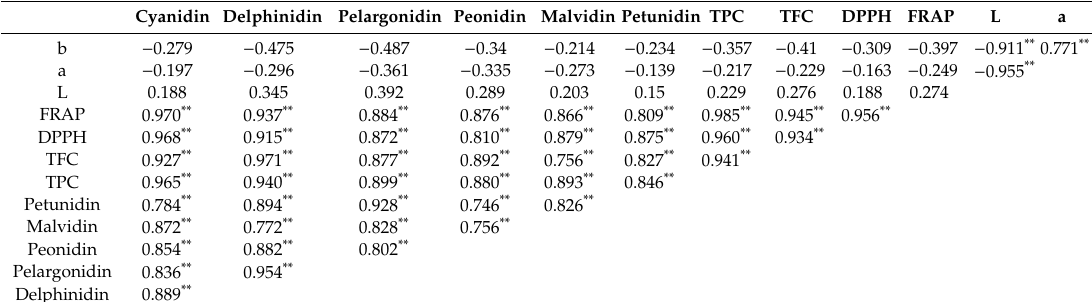
Table 5. Pearson correlations among anthocyanin compounds, total phenolic and flavonoid contents, and antioxidant activities (DPPH and